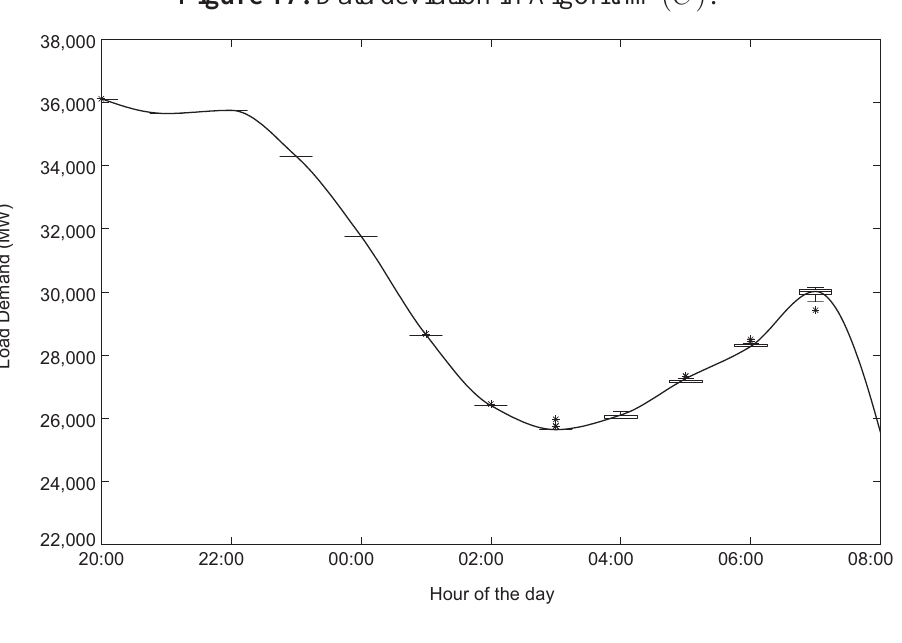
Figure 18. ERCOT January